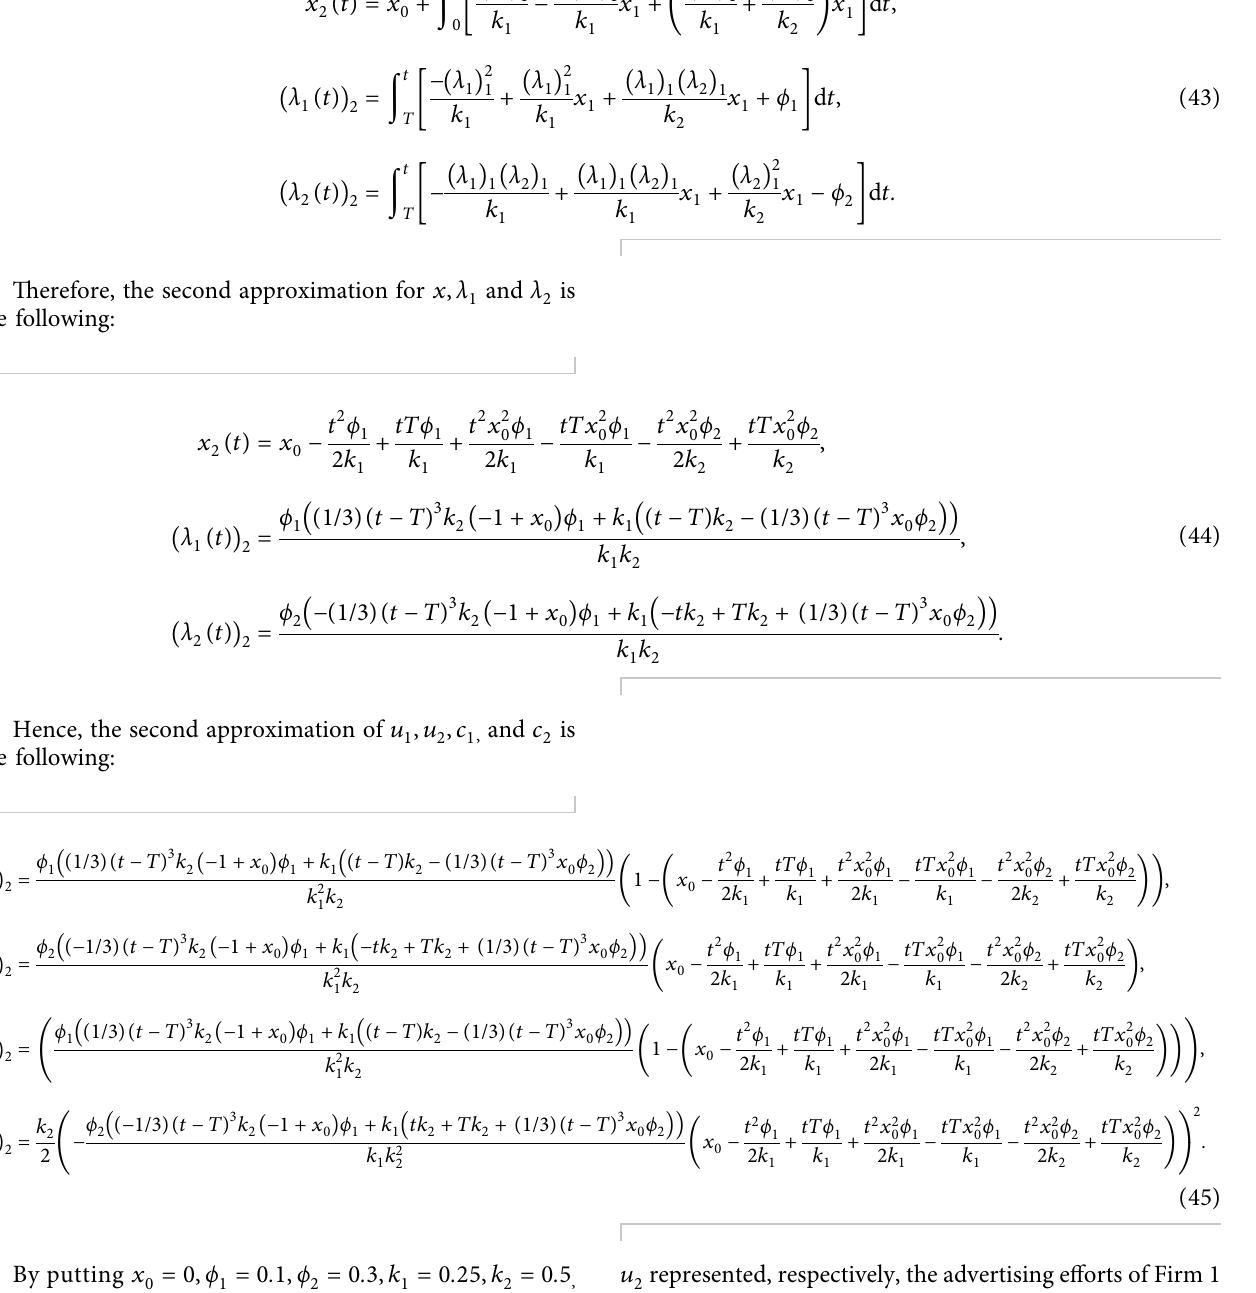
state for our problem. In our example x and 1 − x